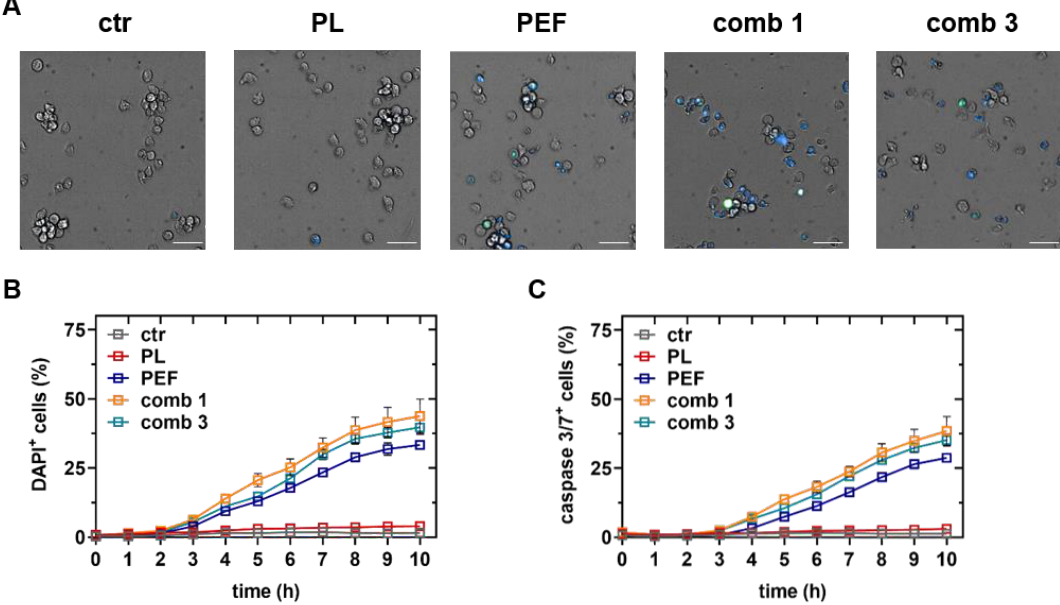
Figure 4. Cell death kinetics using live-cell imaging. The plasma-exposure time was 40 s, and the electric field strength was 0.9 kV/cm. Representative images of brightfield, caspase 3/7 (green), and 4’,6-diamidino-2-phenylindole (DAPI, blue) intensities 10 h after treatment of control, plasma, PEF, plasma plus PEF, and PEF plus plasma treatment ( A ). Quantitative analysis of DAPI ( B ) indicative of terminally dead cells and caspase 3/7 ( C ) indicative of apoptotic cells. Data are shown as one representative ( A ) and mean + S.E. ( B – C ) of three technical replicates from three independent experiments. ctr = control; PL = plasma; PEF = pulsed electric fields; comb = combination. Scale bar is 50 µm.